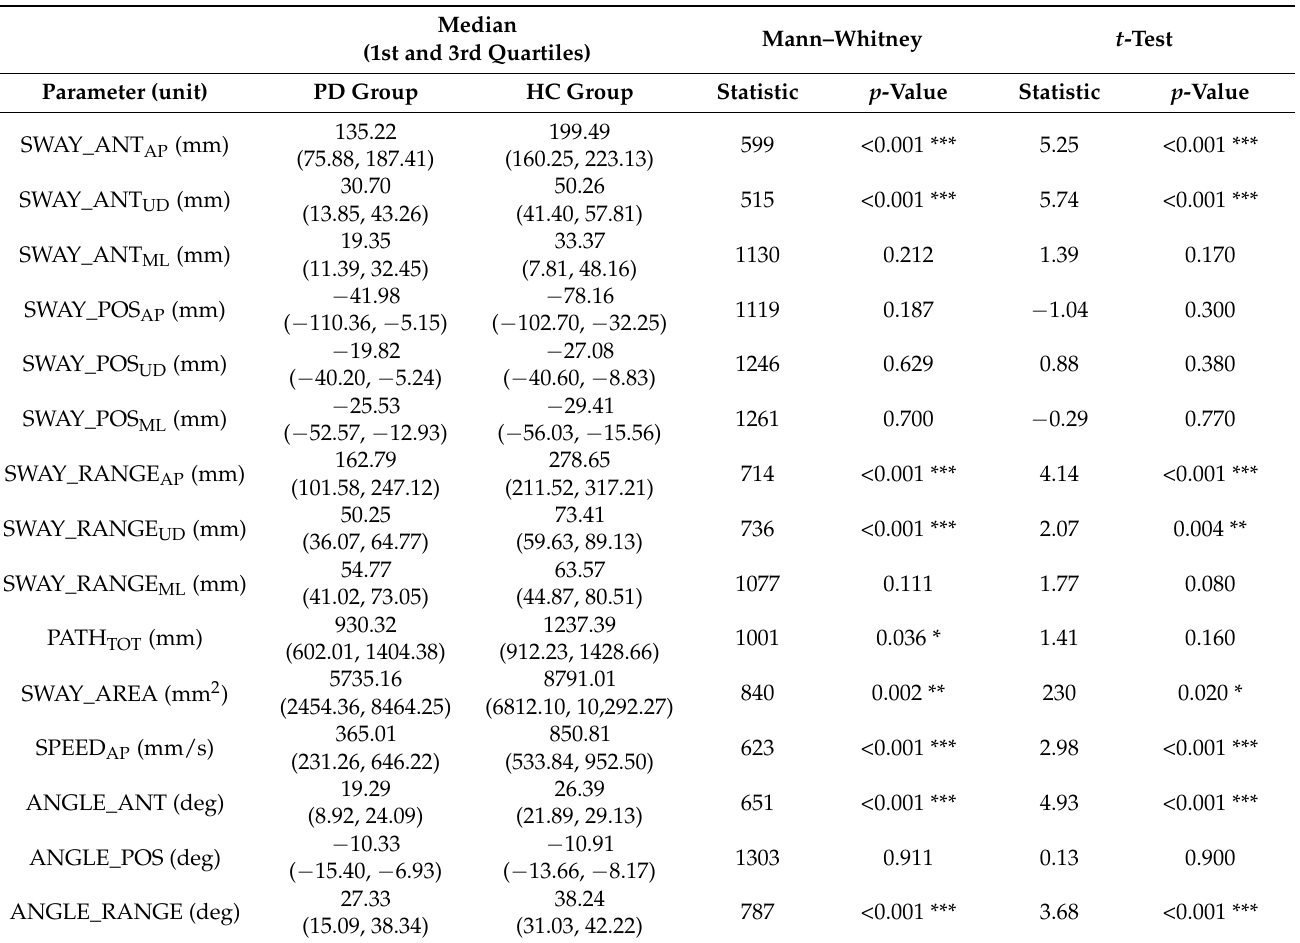
Table 3. Median and quartiles (first and third) relative to arm swing parameters for PD and HC groups, with test statistic, p -value, and significance level. Median (1st and 3rd